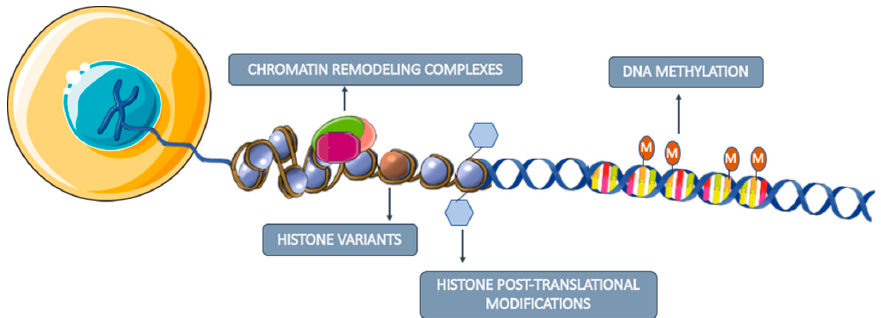
Figure 3. Major studied epigenetic mechanisms involved in gene expression regulation. DNA